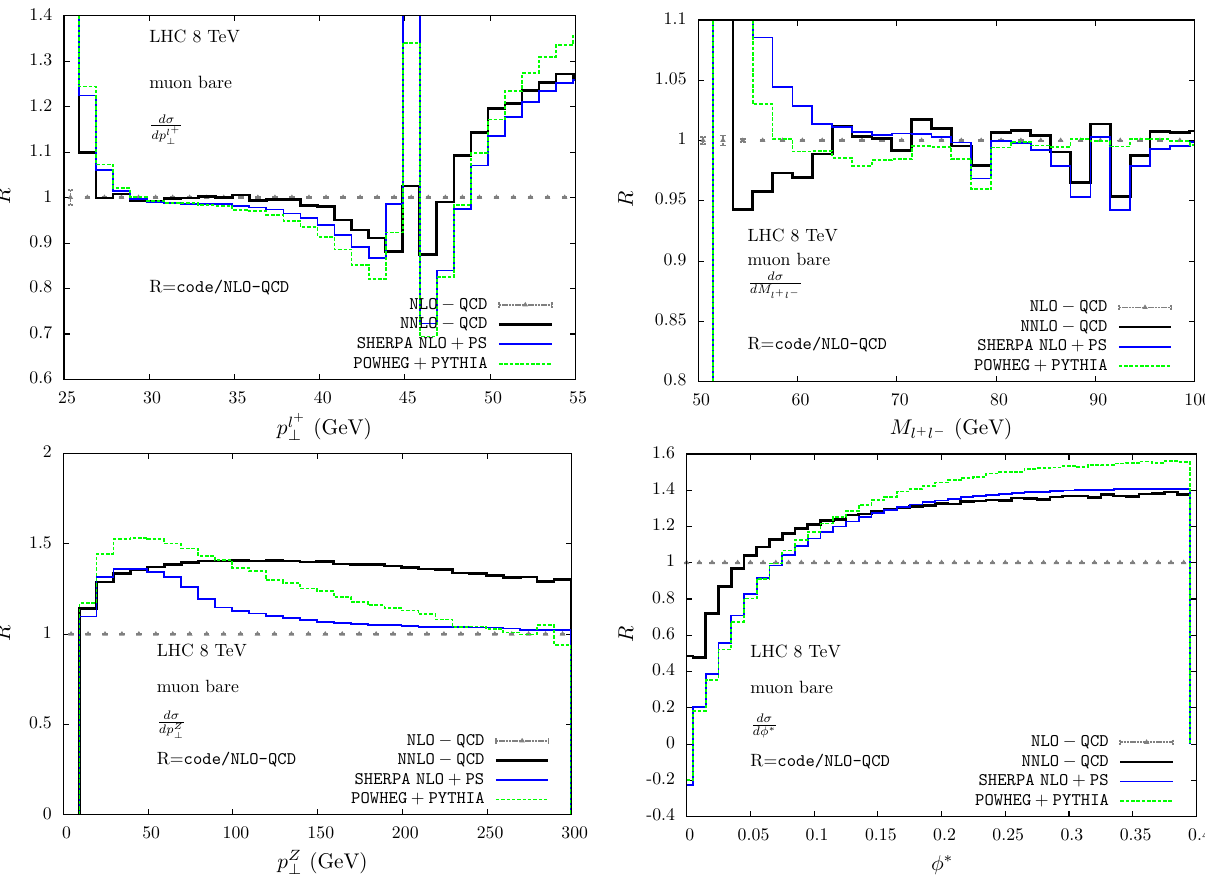
Fig. 21 Higher-order QCD effects, expressed in units of NLO QCD, in pp → μ + μ − + X , due to the matching of resummed and fixed order results, in codes with NLO accuracy: POWHEG + PYTHIA ( green ) and SHERPA NLO+PS ( blue ). The fixed-order NNLO QCD results are